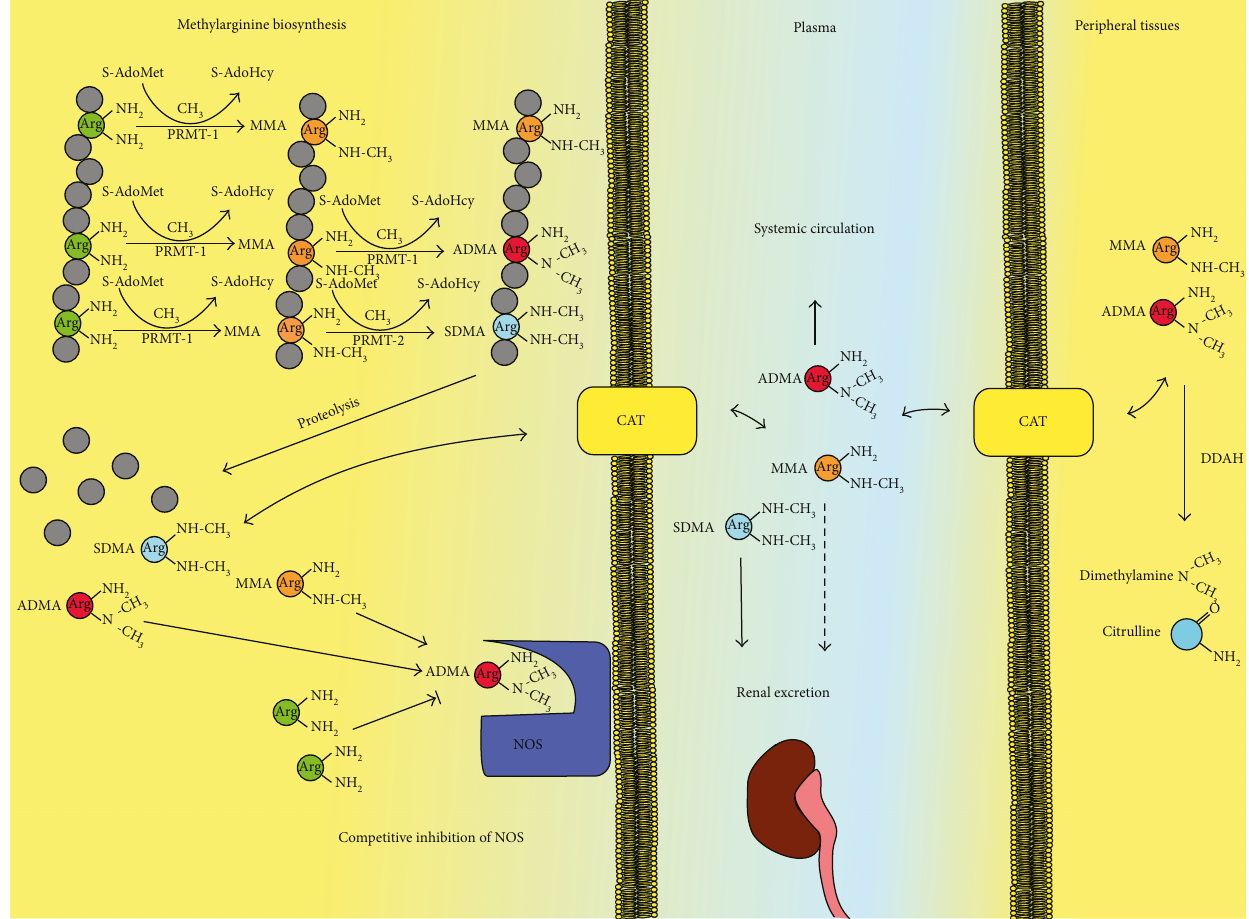
Figure 1: Metabolic pathways of methylarginines. S-AdoMet: S-adenosyl-l-methionine; S-AdoHcy: S-adenosylhomocysteine; PRMT: protein arginine methyltransferases; MMA: monomethyl arginine; ADMA: asymmetric dimethyl arginine; SMDA: symmetric dimethyl arginine; CAT: cationic amino acid transporter; DDAH: dimethylarginine dimethylaminohydrolase; NOS: nitric oxide